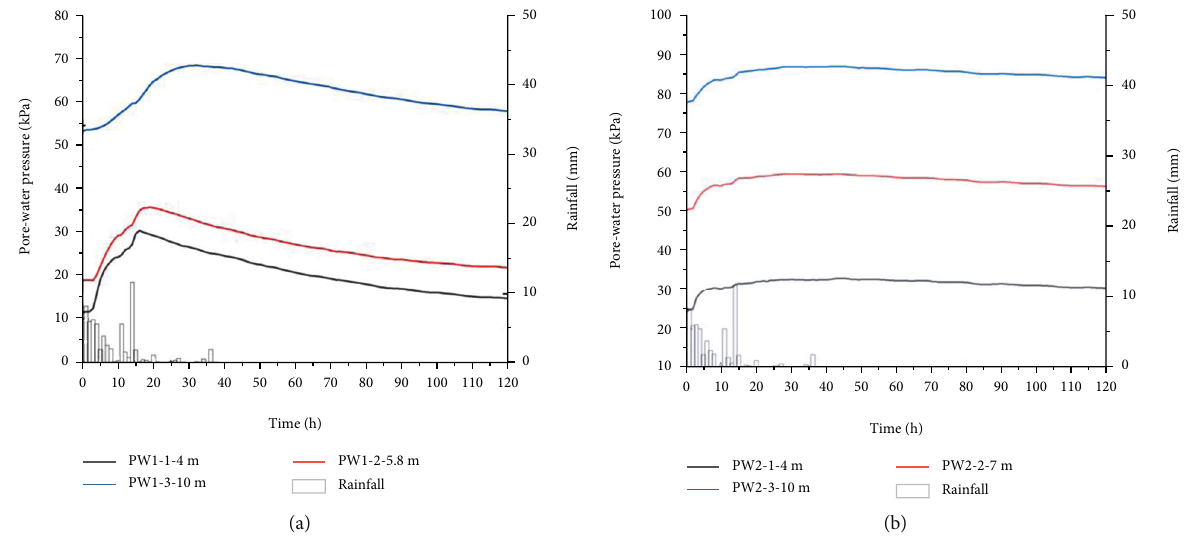
Figure 9: Relationship between rainfall and pore-water pressure during the study period. (a) Monitoring point A. (b) Monitoring point